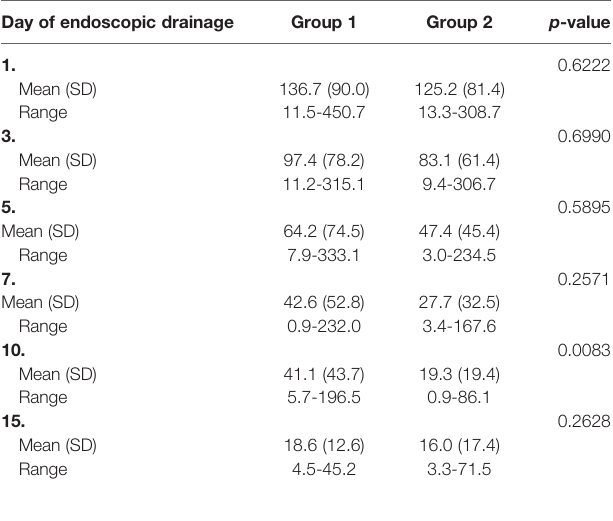
TABLE 5 | Comparison of the results of C-reactive protein (mg/L) in groups of patients during endotherapy. Day of endoscopic